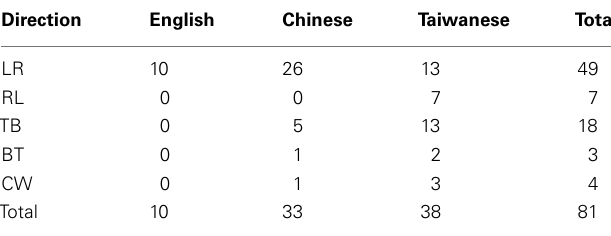
Table 1 |Arrangement direction frequencies by